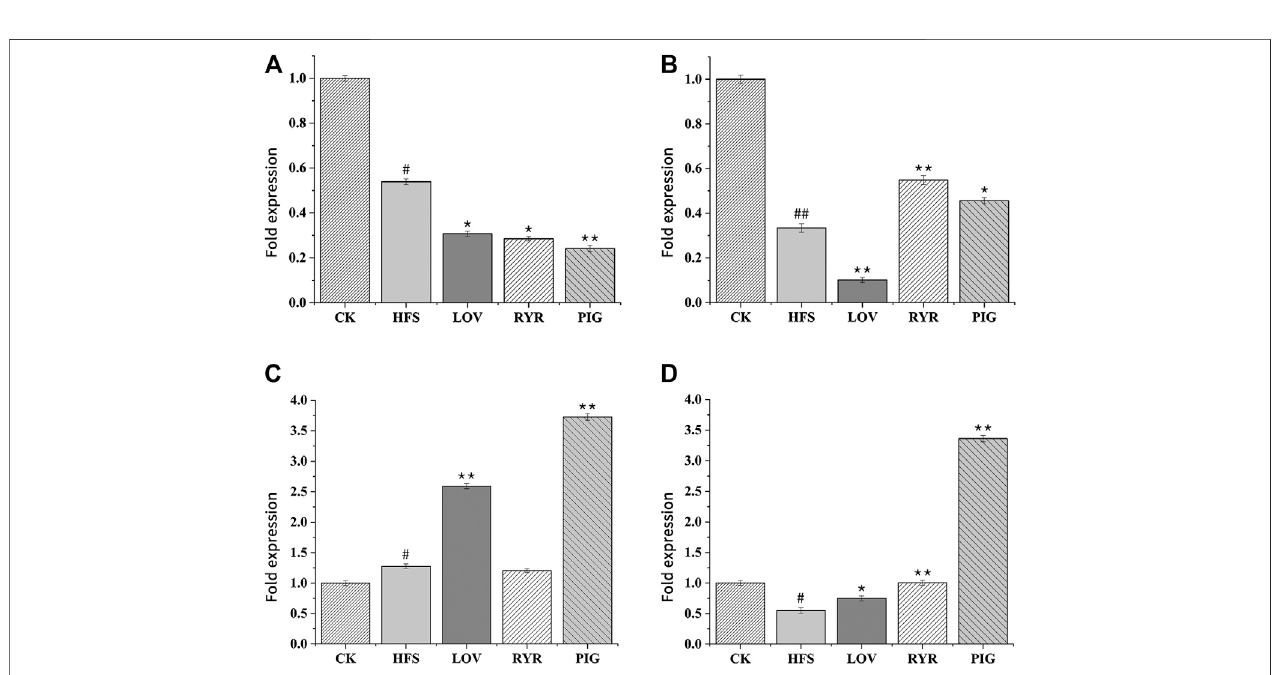
FIGURE7| EffectsofHFS, LOV,RYR, and PIGonmRNA expression inliver-related genesofhyperlipidemic rats(n (cid:2) 3). (A) phosphatidatephosphataseLPIN; (B) CYP2C; (C) sPLA2; (D) CYP7A1.ThemRNAlevelsoftheCKgroupwereusedasthereferencevalue.DatawereexpressedastherelativemRNAlevelforeachgeneand represented as the mean ± SD (n (cid:2)